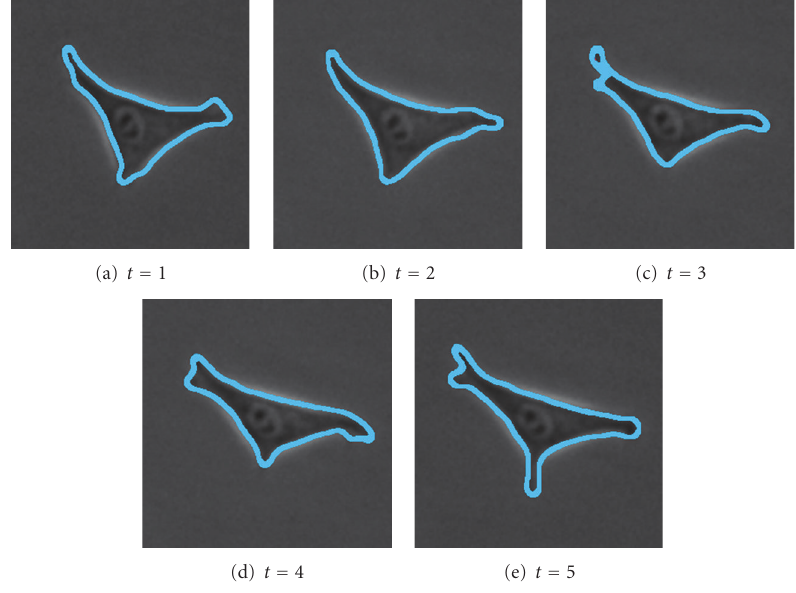
Figure 16: Annotations by a human